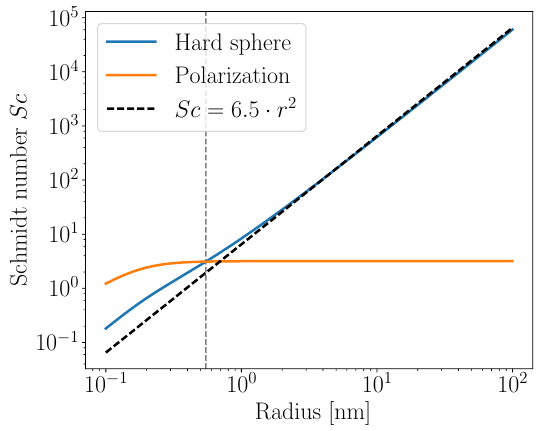
Figure 13. Schmidt number as a function of radius for the two inter- action models (hard sphere: blue; polarization: orange) and the ex- pression found by Lübken et al. (1998) (dashed, black) calculated for the conditions given in Lübken et al. (1998). The grey dashed line indicates the radius where the transition between hard sphere and polarization interaction